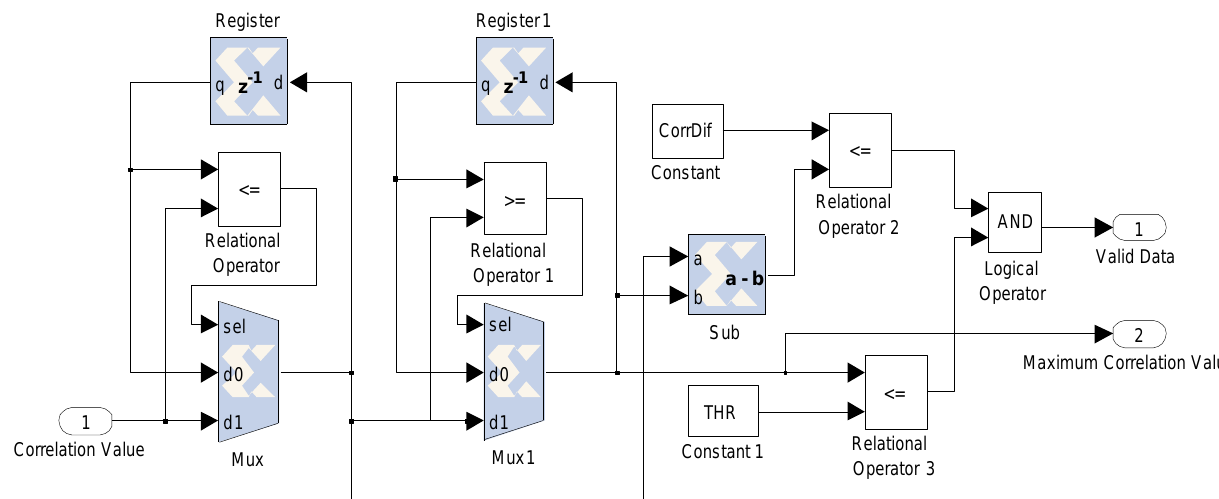
Figure 11. Implementation of ambiguous points